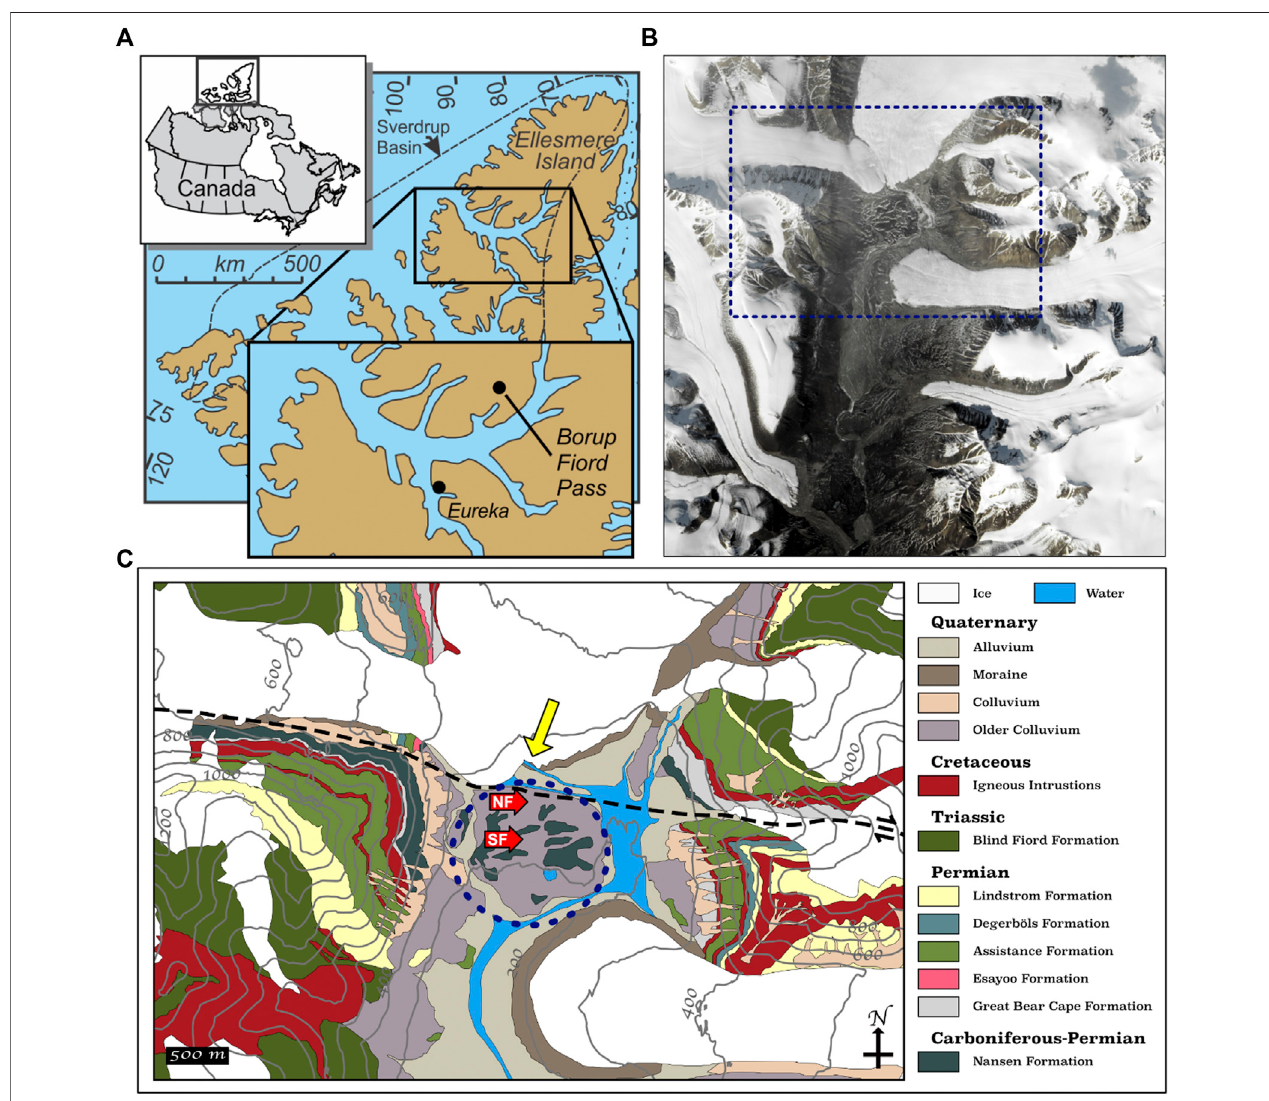
FIGURE 1 | Location and regional geology of Borup Fiord Pass. A line drawing (A) shows the location of Ellesmere Island within the Canadian High Arctic (black- and-white inset). The bottom inset in (A) shows the location of Borup Fiord Pass as well as the location of the Eureka weather station. A satellite image of Borup Fiord Pass (B) was collected on 21 June 2014 by the Operational Land Imager (OLI) onboard Landsat 8 (image credit: NASA Earth Observatory/USGS/J. Allen/R. Simmon). The dashed box in (B) shows the location of the geological map in (C) . A map of regional geology (C) was adapted from Hill (2014). Features in (C) include: ablack dashed line showing the location of a strike-slip fault running across the valley; a large yellow arrow showing where modern sulfur springs emerge at the base of the glacier;ablue dotted circle showing the roughregionwhere pyrite veining and general red staining ofrocks has been observed; and twored- fi lled arrows pointing tothe locations of the North Feature (NF) and South Feature